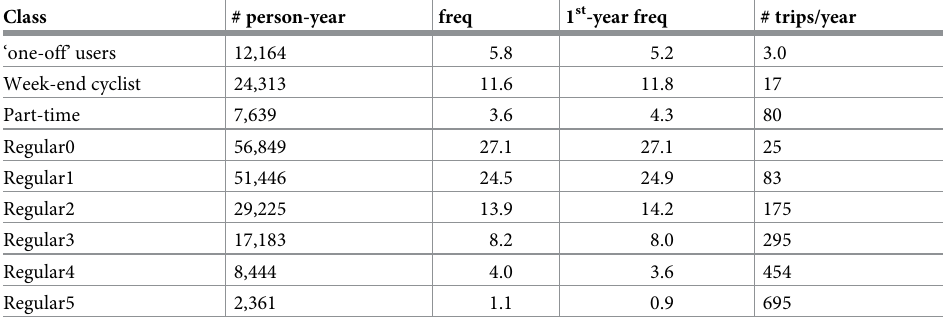
Table 3. Description of user classes found by the k-means for the 21